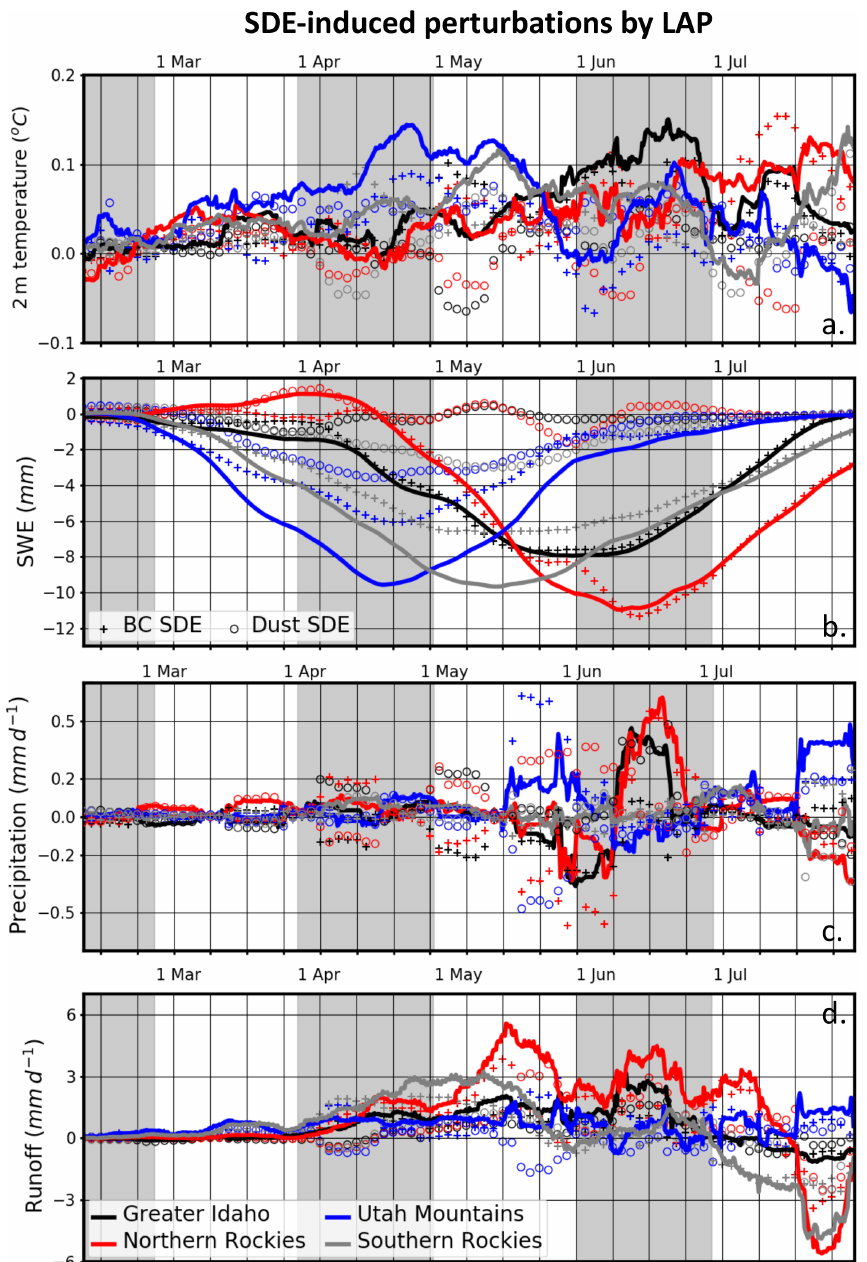
Figure 9. Presented by region are low-pass-filtered time series of perturbations in (a) 2m temperature, (b) SWE, (c) precipitation, and (d) runoff incited by LAP SDE. Solid lines show perturbations due to total (BC + dust) SDEs, while crosses (hollow circles) show perturba- tions due to BC (dust)